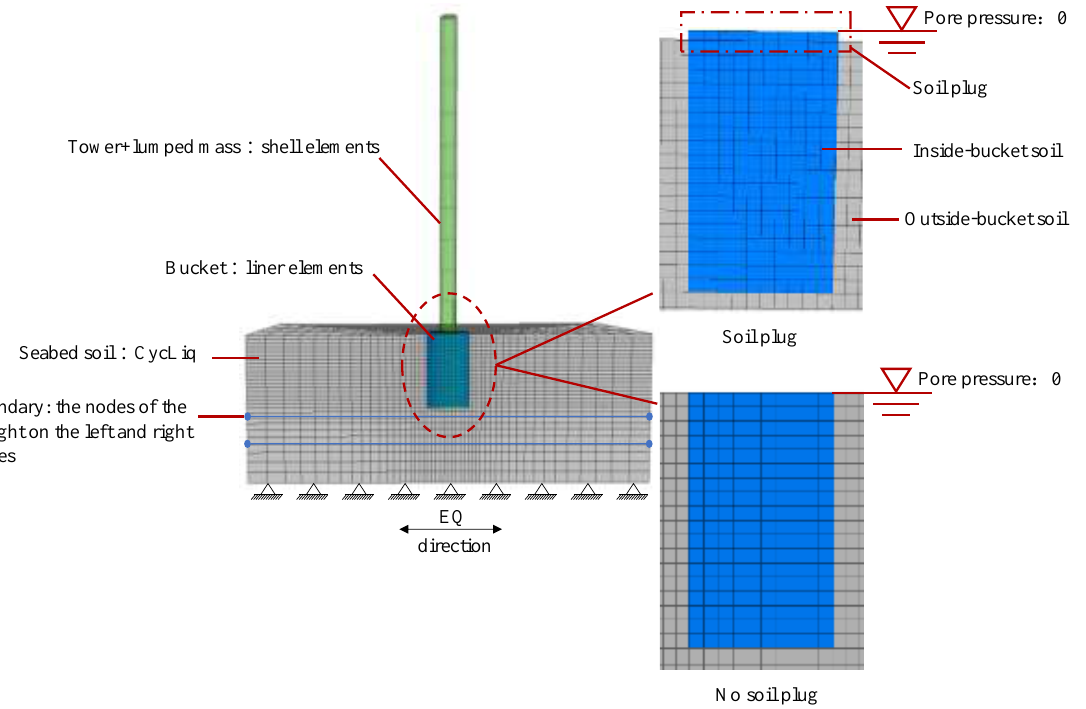
Figure 3. Numerical analysis model for the deep bucket foundation case in FLAC3D.